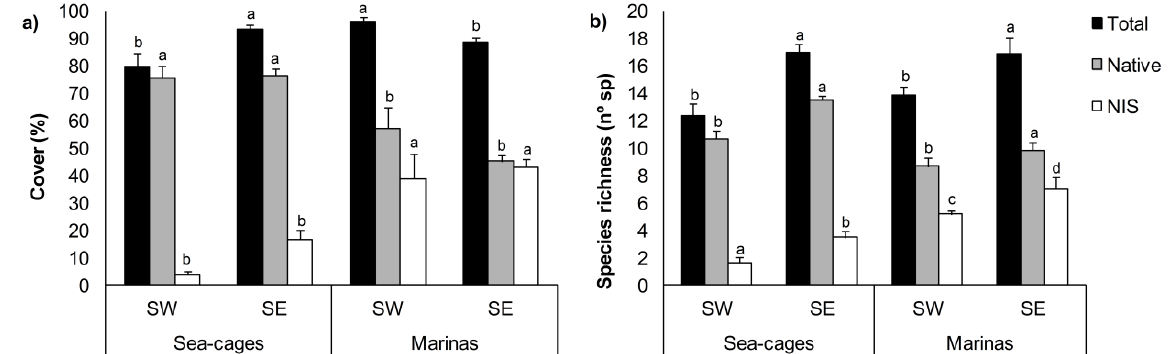
Figure 3. ( a ) Mean cover (% + SE) and ( b ) species richness (mean + SE) of total, native, and non-indigenous species (NIS) across artificial environments (sea-cages vs. marinas) and regions (SW vs. SE). Significances of a posteriori pairwise tests between regions within environments are indicated with different letters ( p < 0.05).